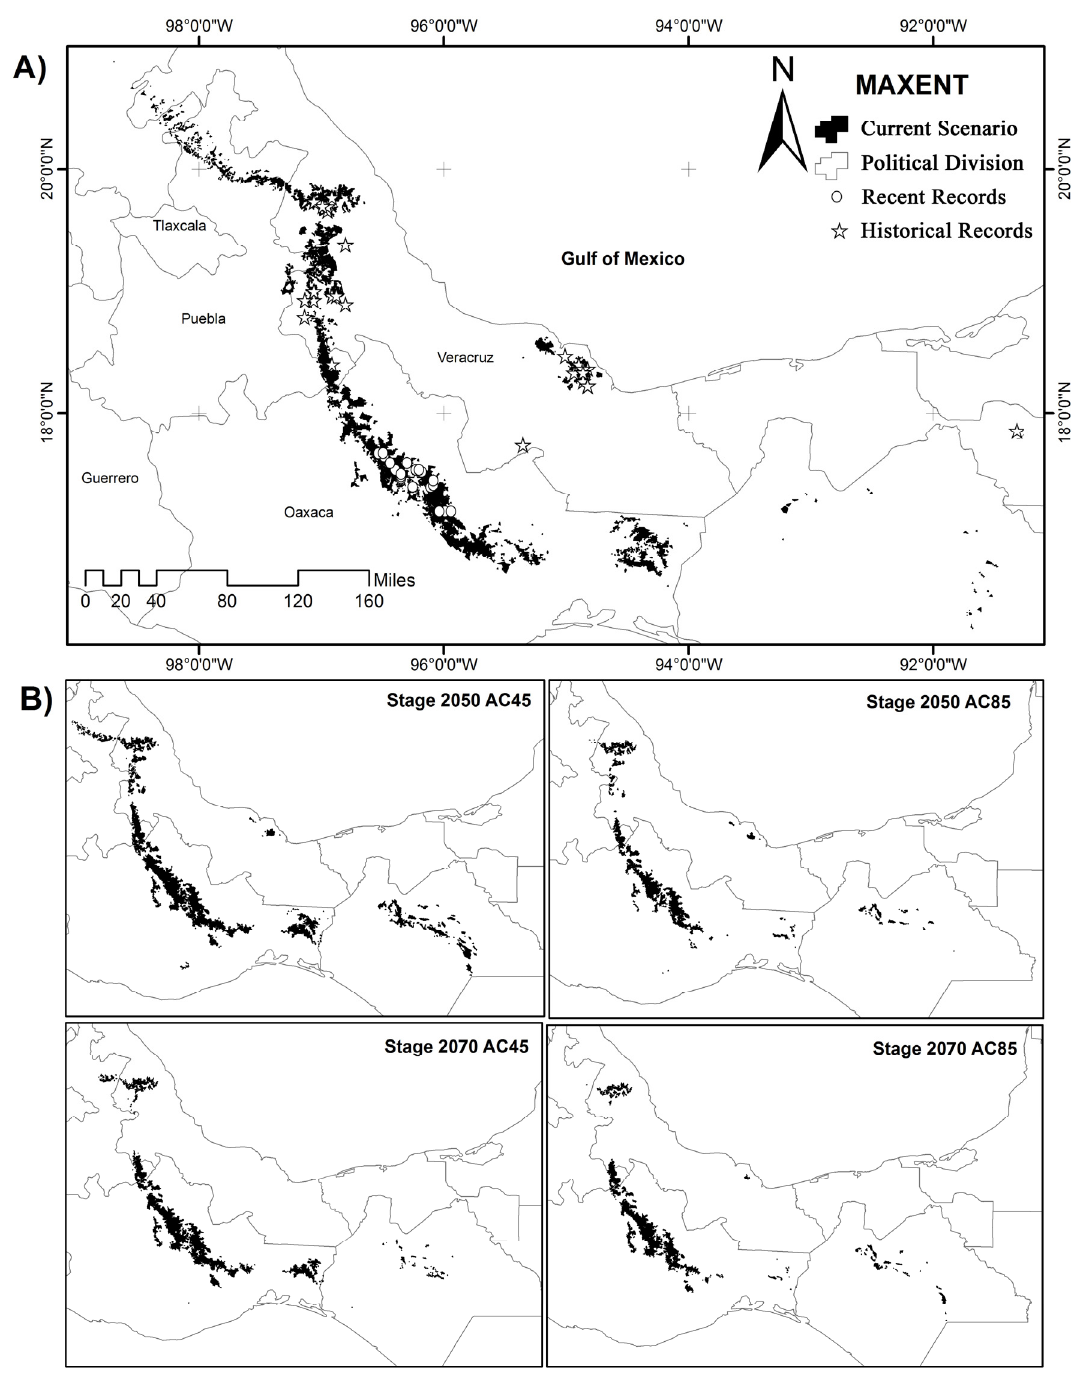
Figure 1. Areas in black indicate the potential current distribution; stars and circle indicate a historical and recent record of O. mexicana ( A ); Suitable potential distribution of the species ( B ) under two Representative Concentration Pathways: the RCP4.5 and RCP8.5 scenarios for the years 2050 and